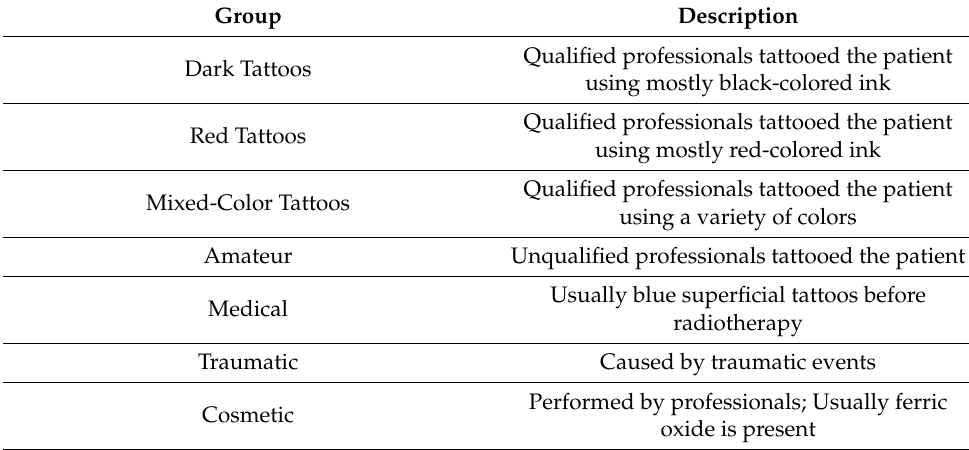
Table 1. Tattoo classes identified and included in the